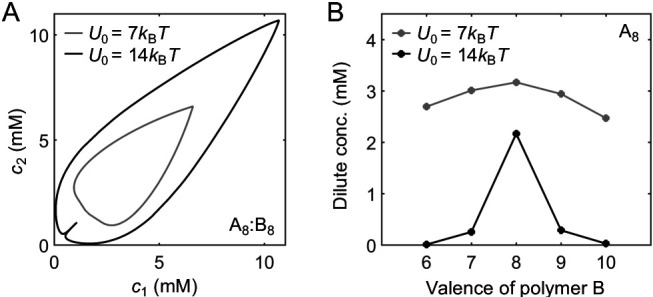
The magic-ratio effect disappears in the weak-binding regime.(A) Phase diagrams for A8:B8 system with different binding strengths U0=7⁢kB⁢T (gray) and U0=14⁢kB⁢T (black). (B) Dilute-phase concentrations for A8:B6-10 systems at equal global sticker stoichiometry with different binding strengths U0=7⁢kB⁢T (gray) and U0=14⁢kB⁢T (black). Parameters: Kb=1.88mM for U0=7⁢kB⁢T, Kb=3.8×10-3⁢mM for U0=14⁢kB⁢T, values of Kd in Appendix 1—table 3, vb=9×10-2⁢mM-1, and wb=7×10-3⁢mM-2. Total global sticker concentration 6.64 mM.